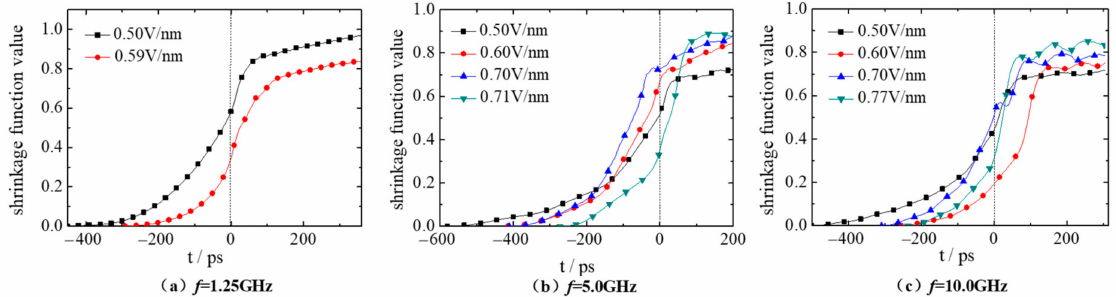
Figure 5. Shrinkage function curve of droplets deformation under AC electric fields with frequency ( a ) f = 1.25 GHz, ( b ) f = 5.0 GHz and ( c ) f = 10.0 GHz.